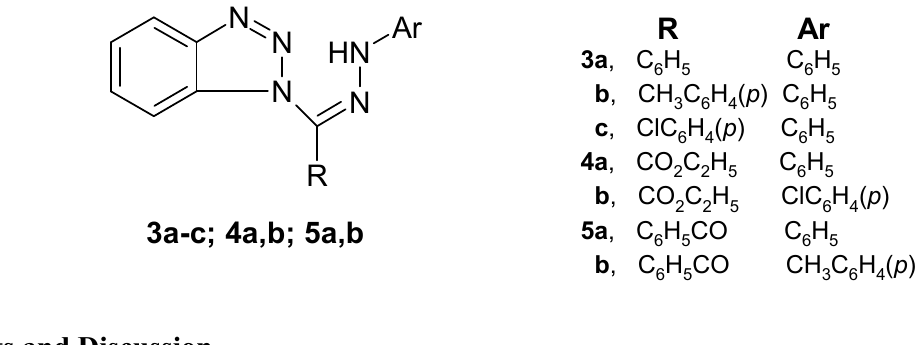
Figure 1. 1-substituted benzotriazole arylhydrzones 3a–c , 4a , b and 5a , b